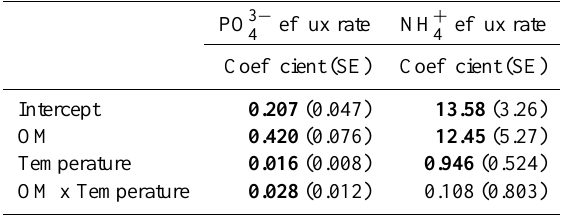
Table 3. Coefficients (means at 26 ◦ C) of the regression model for PO 3 − and NH + sediment–water-column flux (i.e., efflux) rates 4 4 with temperature for nonorganically polluted ( − OM) and organi- cally polluted ( + OM) treatments. Regression model for PO 3 − responds to a first-order polynomial regression, while for NH + corresponds to an exponential regression (Table A1). Significant ef- fects ( p <0.05) are indicated in bold.